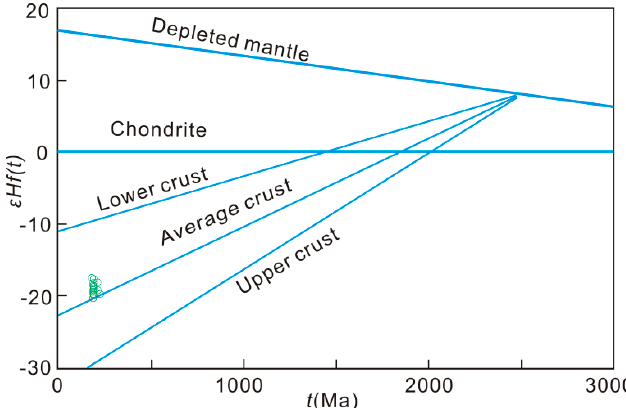
Figure 7. Plots of ε Hf(t) vs. age of zircons. The UCC (upper continental crust) and LCC (lower continental crust) are from Jahn et al. [29].